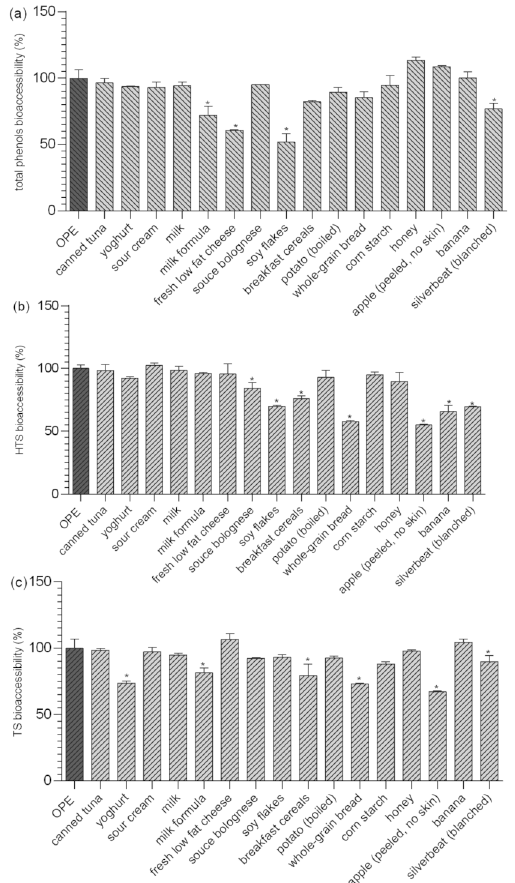
Figure 2. Impact of di ff erent foods on relative bioaccessibility* of total polyphenols ( a ), HTS) ( b ) and TS ( c ) from OPE. * Relative bioaccessibility was calculated in relation to in vitro bioaccessibility of total phenols, HTS, and TS from OPE obtained after simulation of gastrointestinal digestion using FaSSIF / FeSSIF. Columns marked with * di ff er significantly from OPE ( p ≤ 0.05). OPE—olive pomace extract; FaSSGF—fasted state simulated gastric fluid; FaSSIF—fasted state simulated intestinal fluid; HTS—hydroxytyrosol;